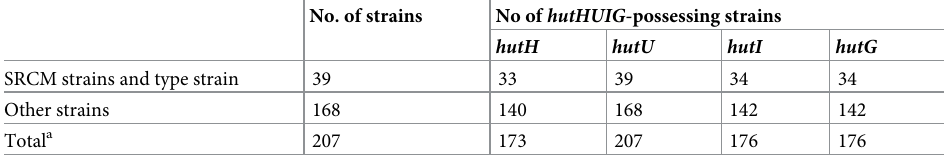
Table 2. Presence of genes involved in potential glutamate production from histidine (analysis of data available as of July 2022). No. of